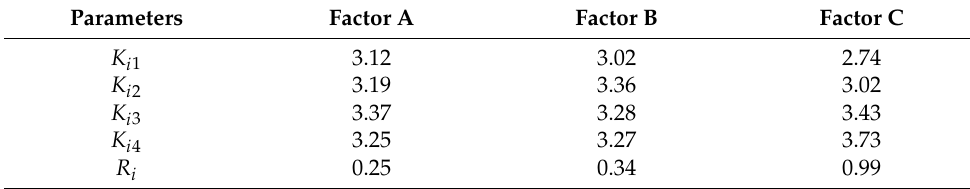
Table 9. Range analysis results for shear